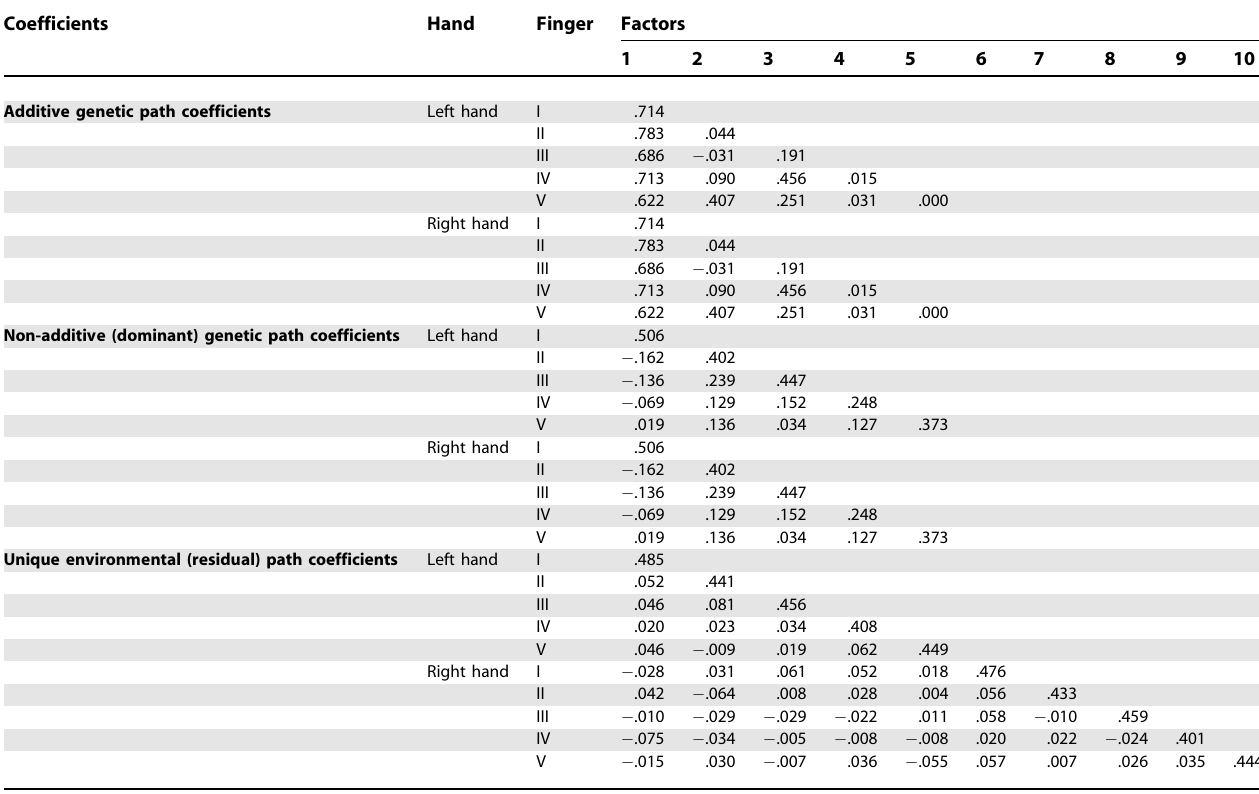
Table 2. Genetic and Environmental Standardized Path Coefficients from the Multivariate (Null) Model in Which the QTL Factor Loadings Were Set to Zero Coefficients Hand Finger Factors